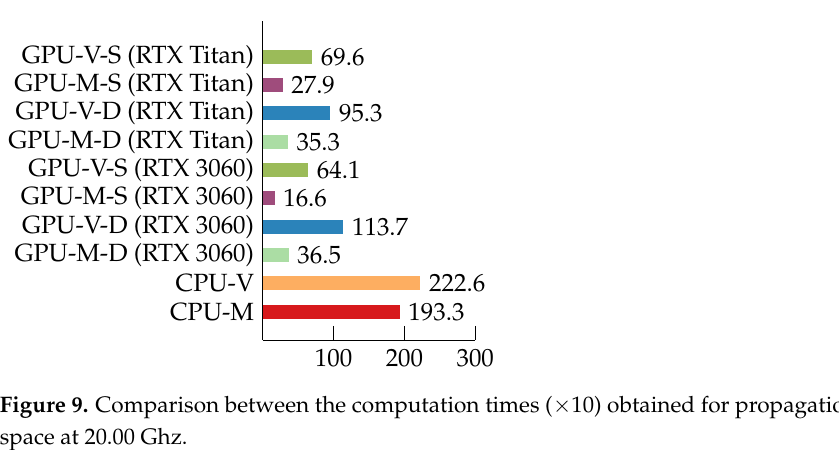
Figure 8. Comparison between the computation times ( × 10) obtained for propagation in open free space at 5.00 Ghz.